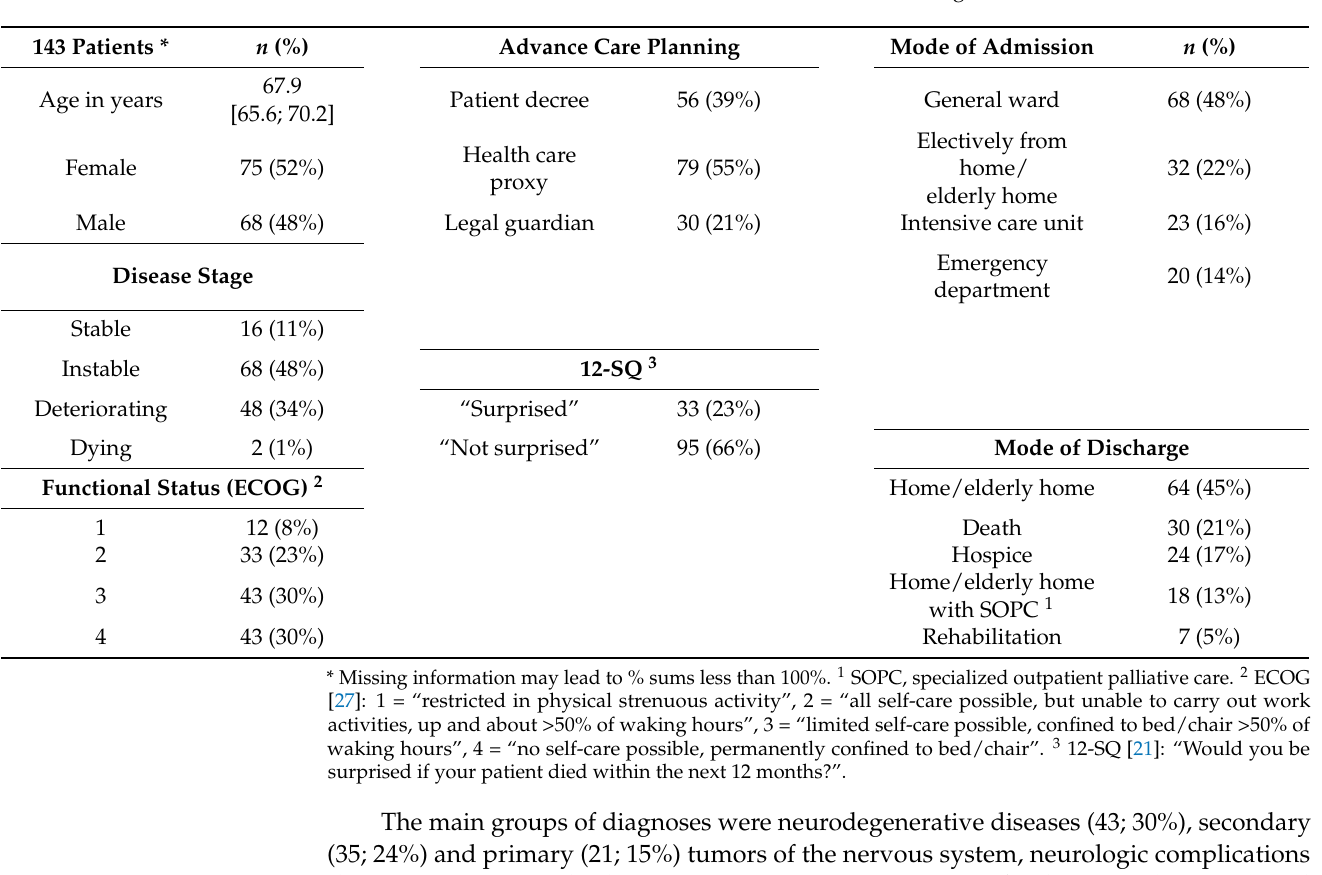
Table 1. Patient characteristics and mode of admission/discharge.